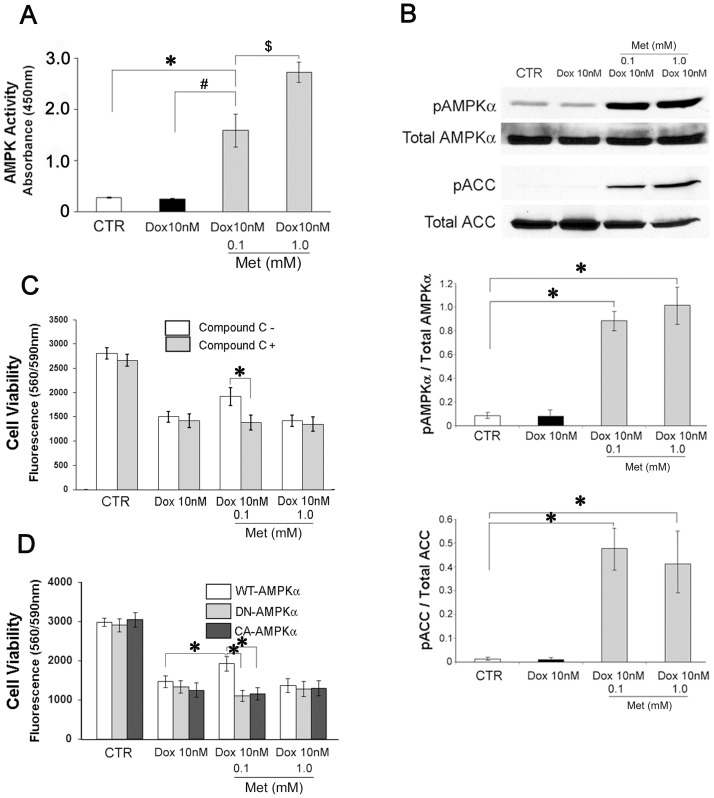
Protective effect of Met against Dox induced cytotoxicity depends on AMPK activity.(A) H9c2 cardiomyoblasts were cultured with reduced FBS (1%) for 72 hours, and then cell lysates were isolated with RIPA buffer supplemented with appropriate phosphatase inhibitors. AMP-activated protein kinase activities in the cell lysates were measured using an AMPK Kinase Assay Kit (Cyclex). (B) H9c2 cell lysates from 72 hour-culture were subject to western blotting using antibodies against phosphorylated or total AMPKα and acetyl-CoA carboxylase (ACC). The histograms show the densitometric scanning results. (C) H9c2 cells were cultured for 72 hours with reduced FBS (1%) in 96-well culture plates under indicated conditions with or without compound-C (10 µM). Cell viabilities were evaluated as described in Materials and Methods. (D) H9c2 cells stably over expressed wild type (WT), dominant negative (DN) or constitutively active (CA) AMPKα cDNA were cultured for 72 hours with reduced FBS (1%) under the indicated conditions. The cell viabilities were evaluated as described. Values represent mean ± S.D. from at least ten (A, C, D) or quadruplicate (B) samples for each treatment at varying treatment conditions. * p<0.05 vs CTR; # p<0.05 Dox 10 nM vs Dox 10 nM + Met 0.1 mM; $ p<0.05 Met 0.1 mM vs Met 1.0 mM (A), * p<0.05 (B, C, D).